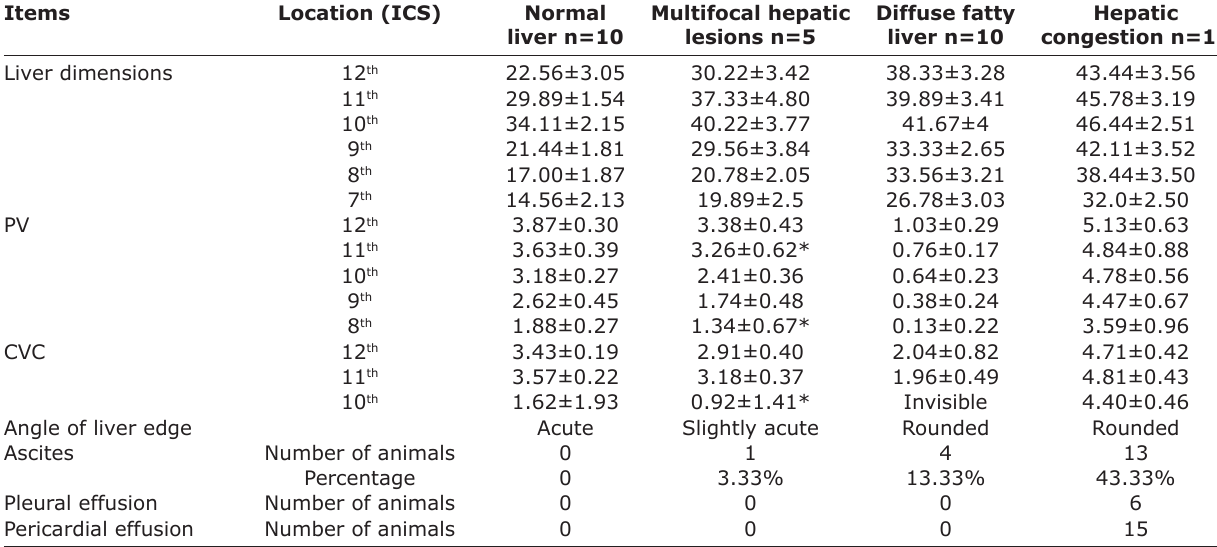
Table-2: Ultrasonographic findings of the normal and affected